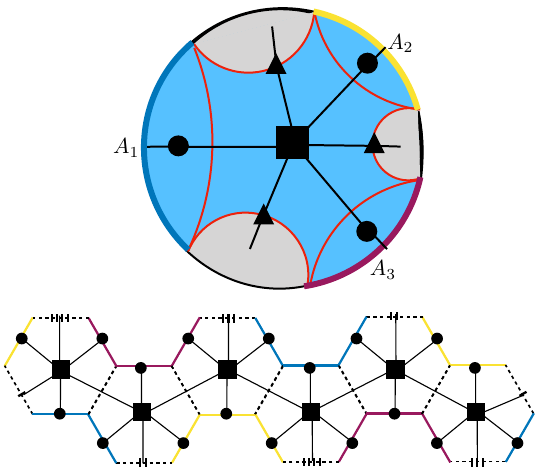
Figure 20 . Top: starting with a tensor for the internal region (square) we can push these legs out to the bounding RT surfaces. For those legs next to one of the boundary regions we can further push the leg out to the boundary (circle). We leave the remaining legs as uncontracted indices (triangle). Below: using these tensor networks we create a new one by contracting legs where ever a gluing is performed. This gives us a new tensor network which approximates the boundary CFT state dual to P